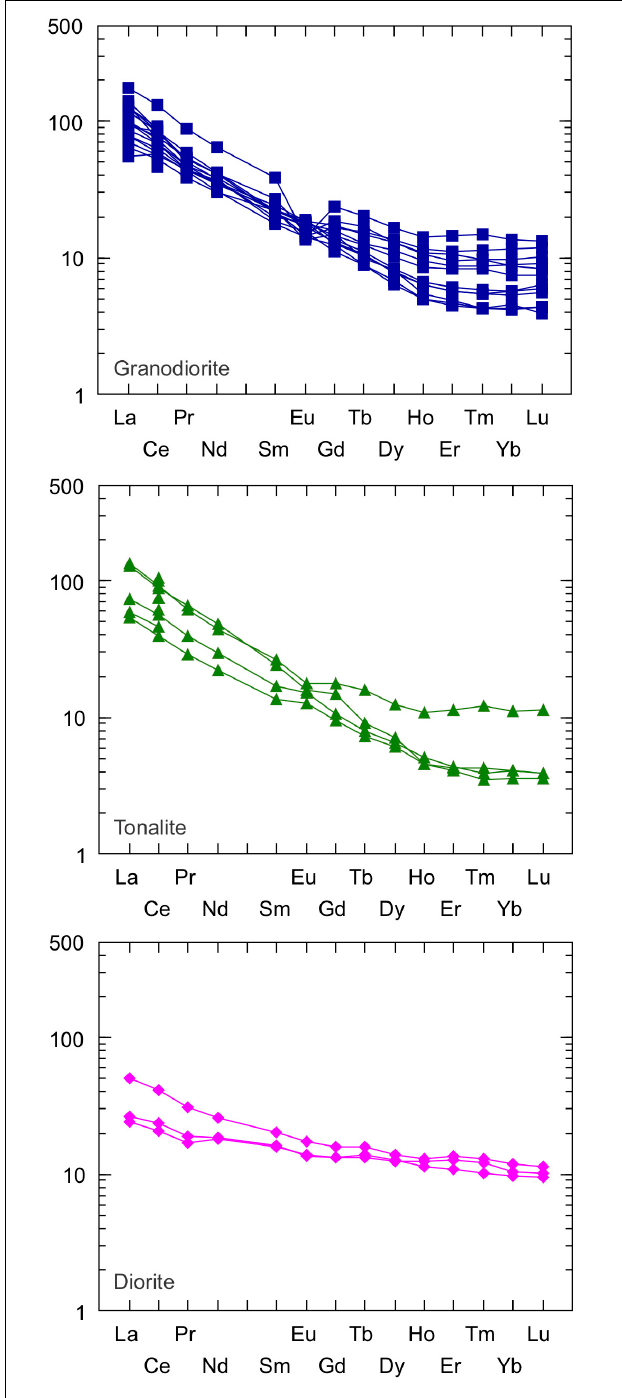
FIGURE 6 | Chondrite-normalized rare earth element patterns of the Cretaceous (A) granodiorites, (B) tonalites, and (C) diorites from Kyushu. Chondrite values are from Sun and McDonough (1989).